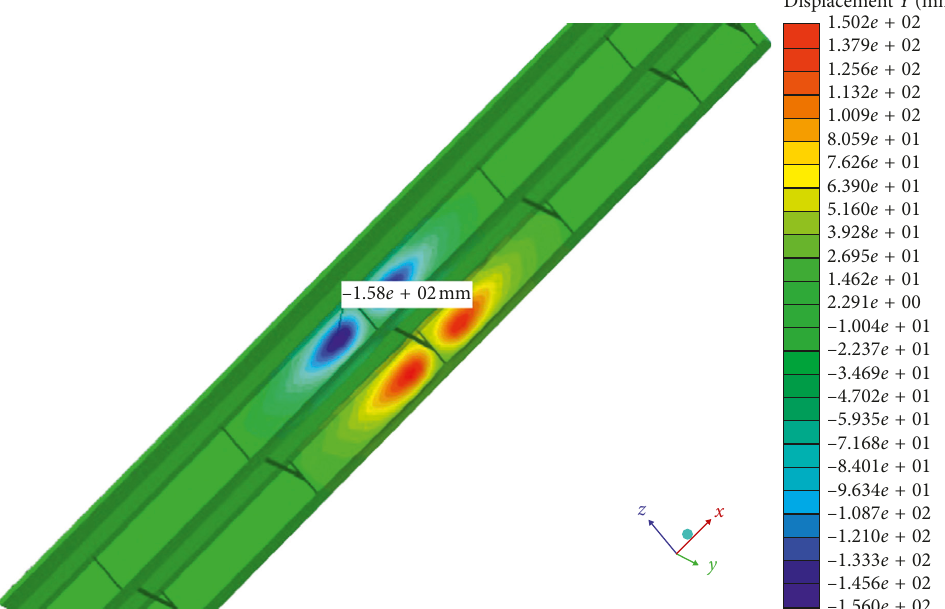
Figure 13: Deformation suffering from explosive